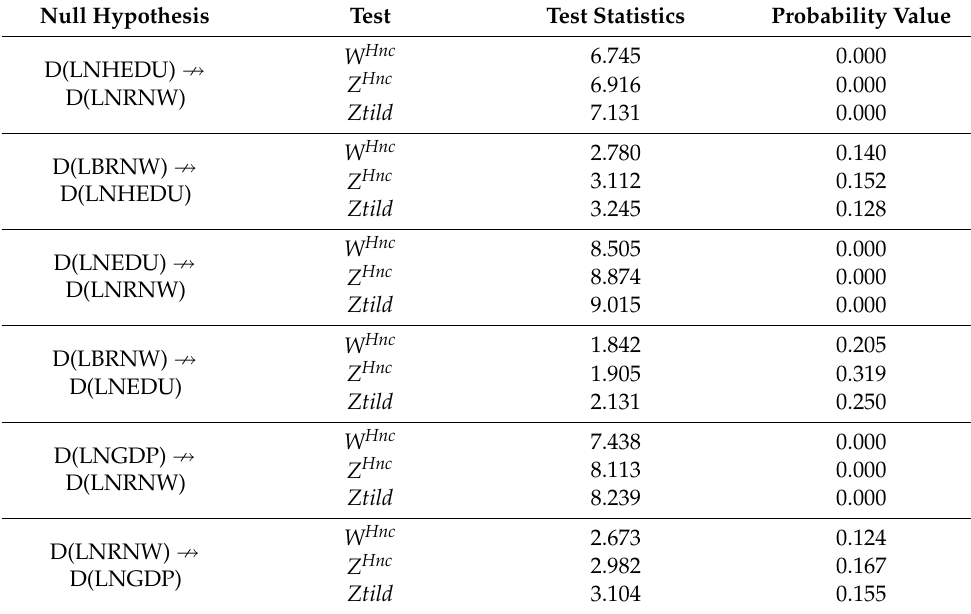
Table 9. Causality test